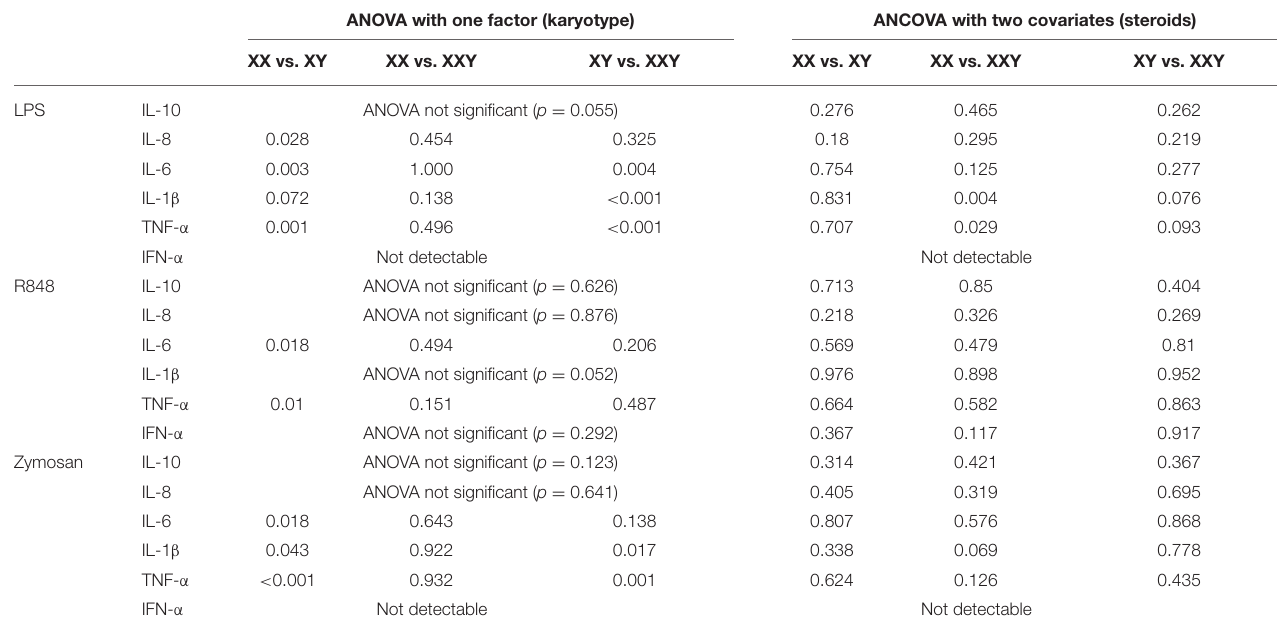
TABLE 2 | Comparison of p values obtained with one-way ANOVA with one group factor (karyotype) at three levels (XX, XXY, XY), and p values obtained with one–way ANCOVA with estradiol and testosterone as covariates, performed on the levels of cytokines secreted in whole blood after stimulation with LPS, resiquimod and zymosan. ANOVA with one factor (karyotype) ANCOVA with two covariates (steroids)